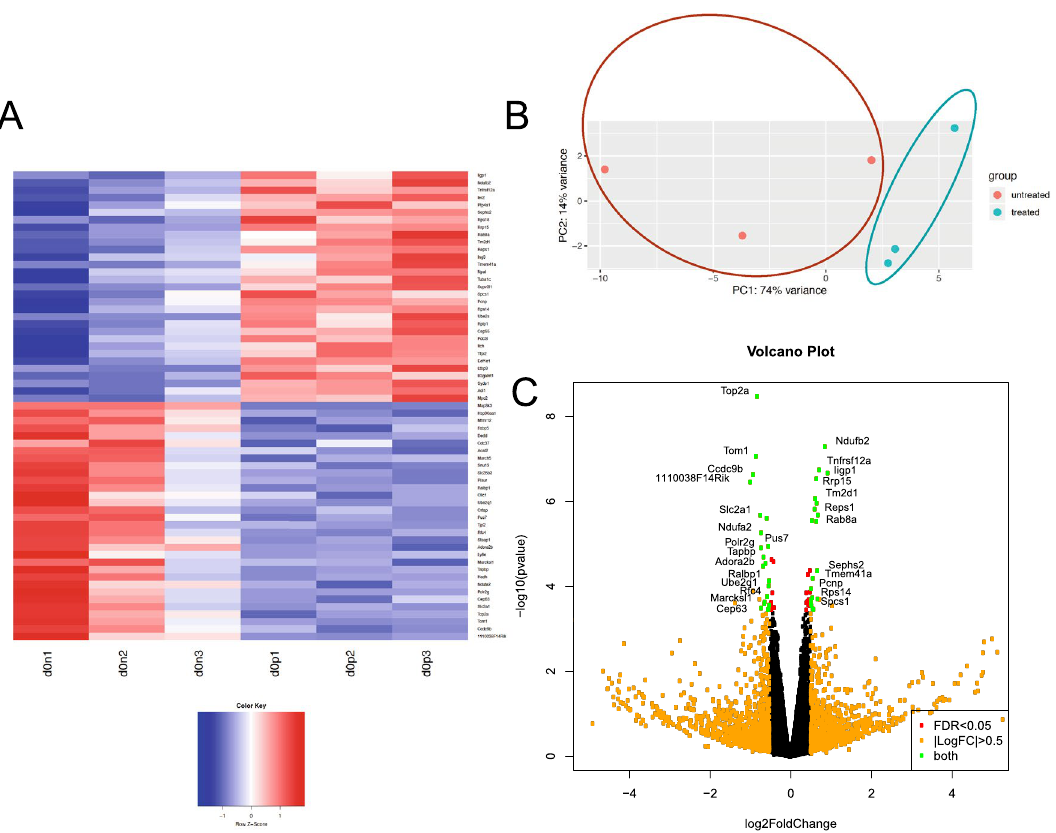
Figure 4. Differentially expressed genes in non-ciliated 3T3-L1 cells treated with 100 nM MCH. ( A ) A heatmap illustrating agreement between triplicate RNA-Seq datasets comparing expression changes between MCH treated (d0p1,2,3) untreated (d0n1,2,3) conditions with p < 0.05. Each row illustrates a gene. Red colors indicate increased gene expression in MCH-treated samples. Blue indicates decreased gene expression in MCH-treated samples. ( B ) Principal component analysis (PCA) was used to show that samples cluster into two major groups, where the first two principal components were plotted (PC1 and PC2). ( C ) Volcano plot illustrates those genes that passed prefiltering criteria. Genes with |LogFC:Fold Change|> 0.5 are shown in orange; genes with FDR < 0.05 are shown in red; with those in green passing both criteria; some of which are